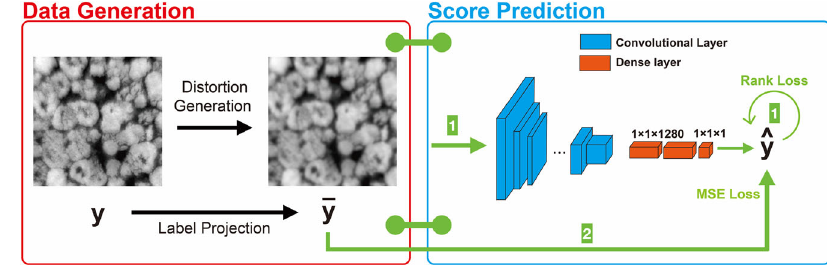
Fig. 1 Pipeline of our TIQA method. It is composed of two modules: data generation and score prediction. In score prediction, (1) is the self- supervised learning for ranking the images and (2) is the fi ne tune procedure for regressing the ranks to a score in a fi xed